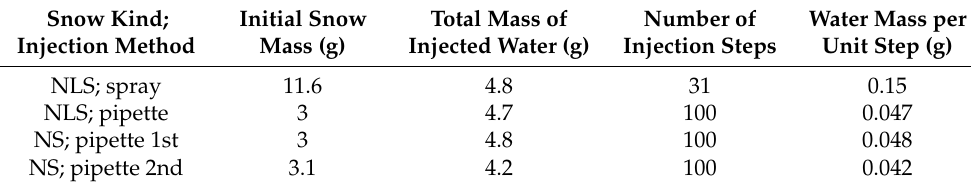
Table 2. Experimental parameters adopted to add liquid water to the snow